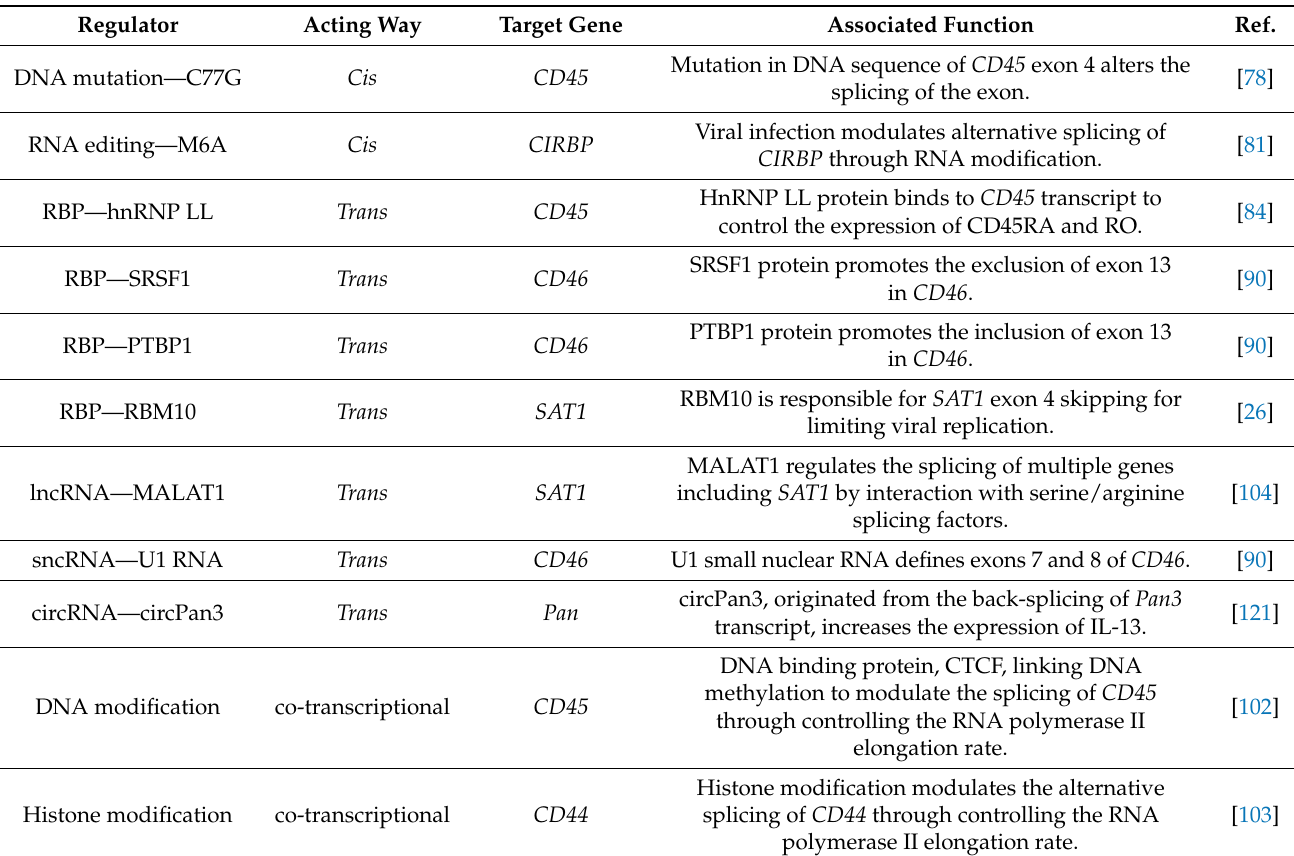
Table 1. The representative splicing regulators associated with